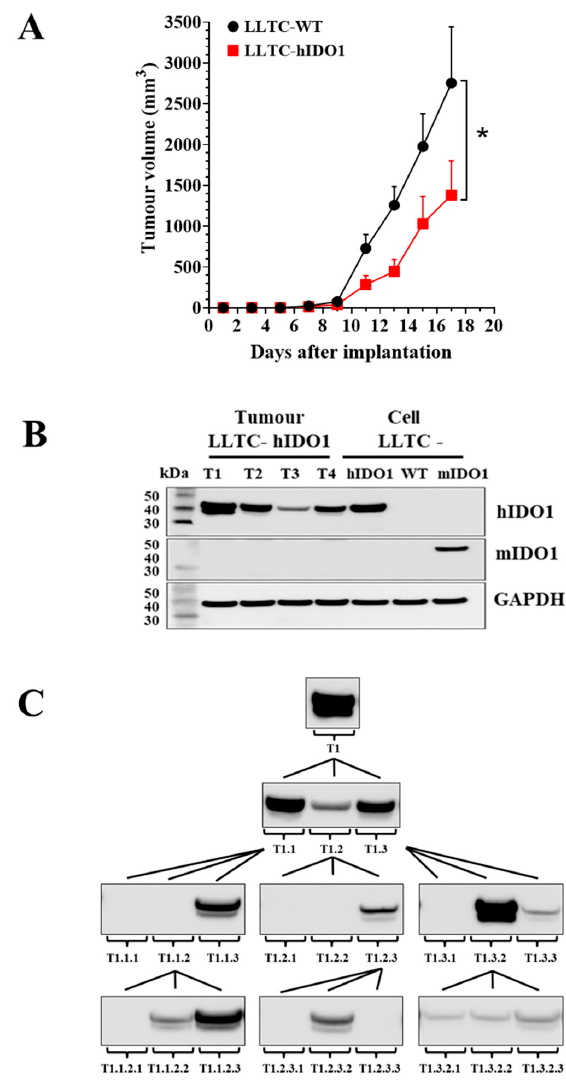
Figure 2. ( A ) Growth of LLTC-WT (black circle) and LLTC-hIDO1 (red square) subcutaneous tumours in C57Bl/6 mice (mean ± s.e.m. of n = 6 per group). p -values determined using two-way Anova and * denotes significance p ≤ 0.05. ( B ) Western blot of hIDO1 or mIDO1 protein in four individual 14-day LLTC-hIDO1 tumours (T1–T4) and in LLTC-hIDO1, LLTC-WT and LLTC-mIDO1 cells. ( C ) Western blots of hIDO1 expression in individual 22-day tumours from sequential generations of implants from a high-IDO1-expressing LLTC-hIDO1 tumour (T1).